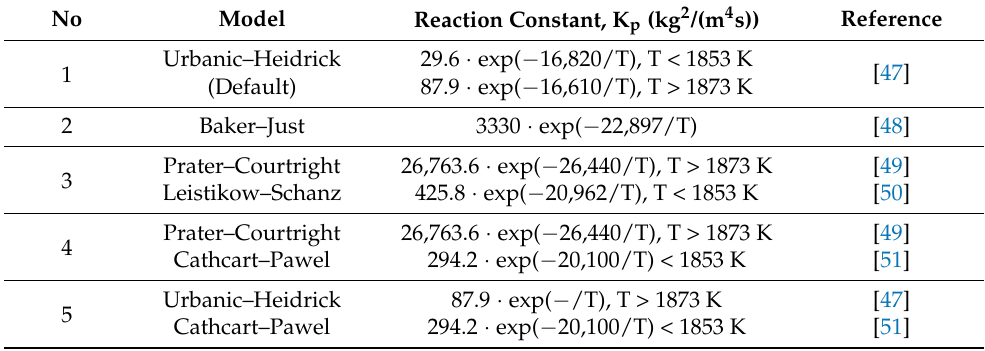
Table 3. Parabolic models for Zr oxidation, reactions with